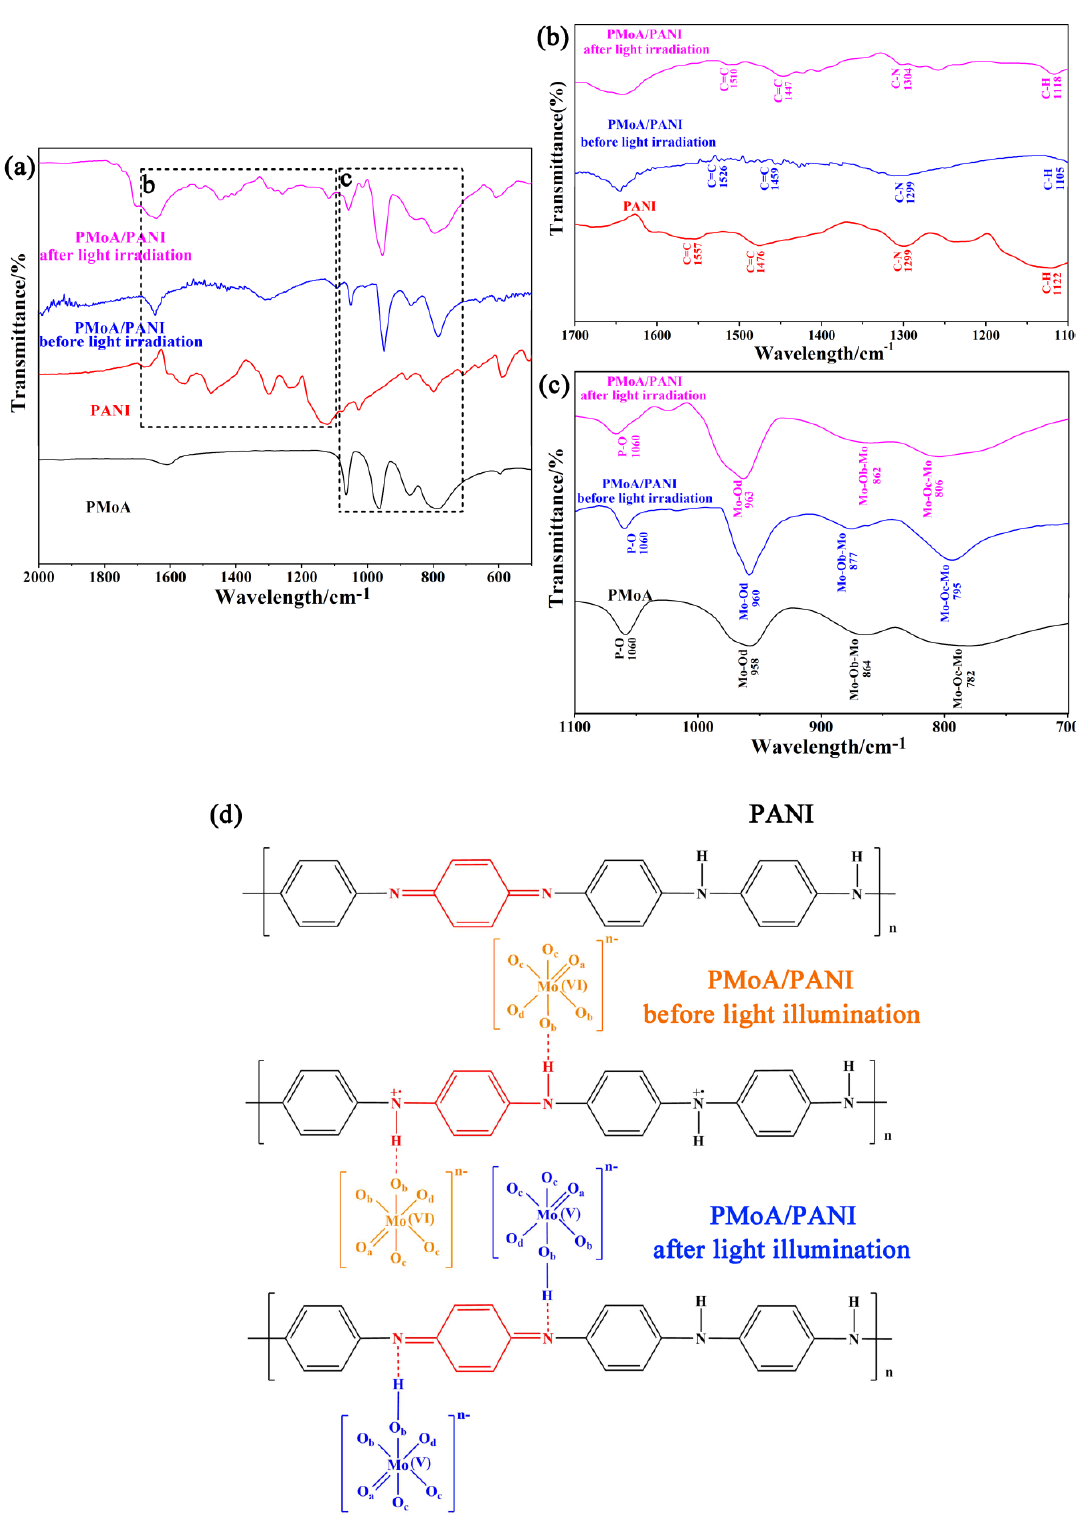
Figure 2. ( a ) FTIR spectrogram of PMoA, PANI, and the PMoA / PANI hybridizing thin film before and after optical-light illumination. ( b ) FTIR spectrogram in the PANI region of PANI and PMoA / PANI before and after optical-light illumination. ( c ) FTIR spectrogram in the PMoA region of PMoA and the PMoA / PANI hybridizing thin film before and after optical-light illumination. ( d ) Chemical structures of PANI and the PMoA / PANI hybridizing thin film before and after optical-light illumination.